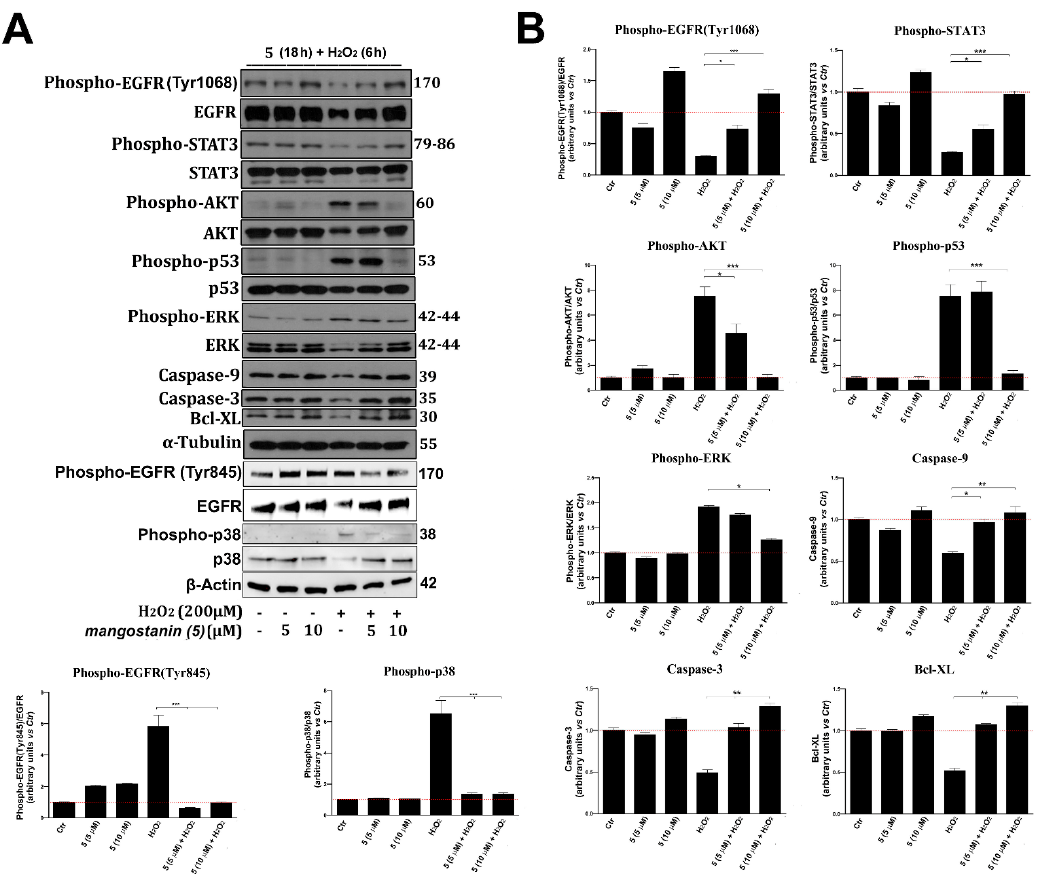
Figure 6. ( A ) WB analysis of EGFR, STAT3, AKT, p53, p38, ERK (total and phosphorylated), Caspase-9, Caspase-3, and Bcl-XL in whole cell lysates from keratinocytes cultured for 18 h with or without mangostanin (5 and 10 µM) and H 2 O 2 (200 μM) for 6 h. As protein loading housekeeping, α - t ubulin or β -actin were used. A representative WB of three different experiments performed with simi- lar results is showed. ( B ) Histograms represent means ± SD in densitometry units of scanned immunob- lots from the 3 different experiments (ANOVA, * p < 0.05, ** p < 0.01, *** p < 0.001, vs. control).